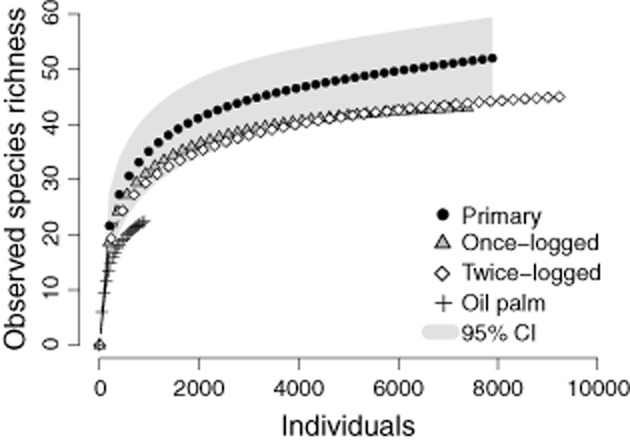
Observed species richness, calculated from sample-based rarefaction curves and scaled to show the number of individuals on the x-axis for dung beetles across a disturbance gradient. Grey shading represents 95% confidence interval (CI) of primary forest.